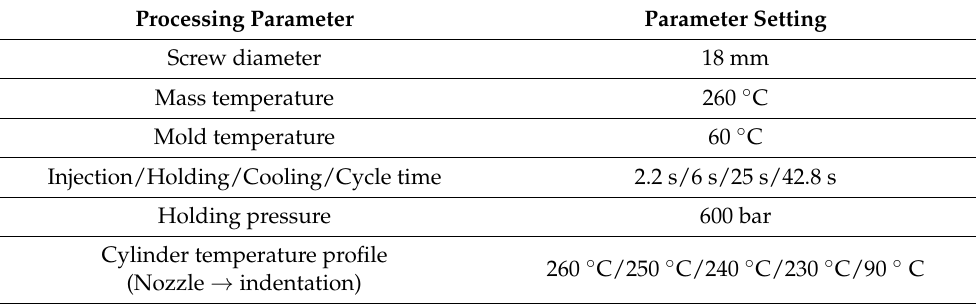
Table 2. Main processing parameters for the manufacturing of the plastic gears.